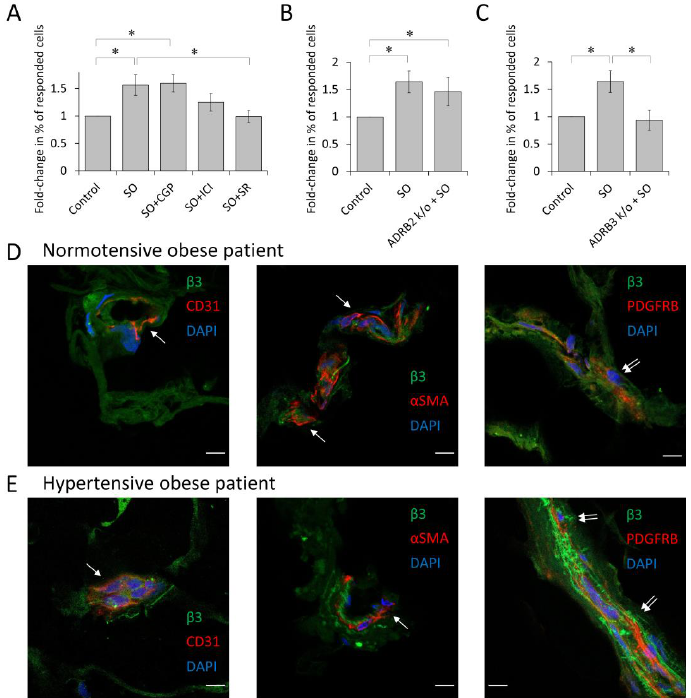
Figure 4. β 3-adrenergic receptors are responsible for alpha1A-adrenoceptors up-regulation in MSCs. ( A ) Fold-change in the percentage of MSCs responded to noradrenaline after sympathetic overdrive (SO) or sympathetic overdrive in the presence of the β 1-antagonist CGP20712 (100 nM, CGP), β 2-antagonist ICI118551 (50 nM, ICI), or β 3-antagonist SR59230A (250 nM, SR) ( n = 12–19). ( B , C ) Fold-change in the percentage of cells that responded to noradrenaline after sympathetic overdrive of either control ASC52telo cells (SO) or cells after ADRB2 ( B ) or ADRB3 ( C ) knockout ( n = 4–7). ( D , E ) Confocal images of frozen sections of human subcutaneous adipose tissue. β 3-adrenoceptor localized in PDGFR β positive MSCs in vessels of subcutaneous adipose tissue of normotensive patients with obesity ( D ) and hypertensive ( E ) patients with obesity (double arrow). Cells expressing β 3-adrenergic receptor (green), CD31 positive endothelial cells (red), alpha smooth muscle actin positive cells (red), and PDGFR β positive MSCs (red). Nuclei stained with Dapi (blue). Scale bar 10 µ m. * p < 0.05 calculated with Kruskal–Wallis and one way ANOVA on